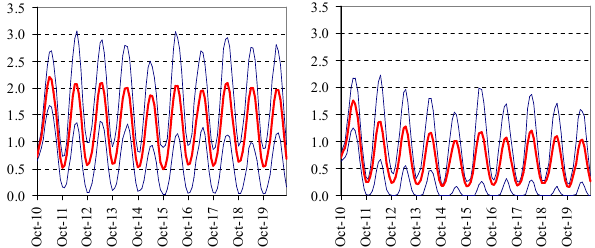
Fig. 8. Simulated discharge (m 3 s − 1 ) at Mavroneri springs (mean Figure 8 and 50% prediction limits) under the actual abstraction policy (left) and the intensive abstraction policy (right) for the water supply of Athens, according to modelling framework